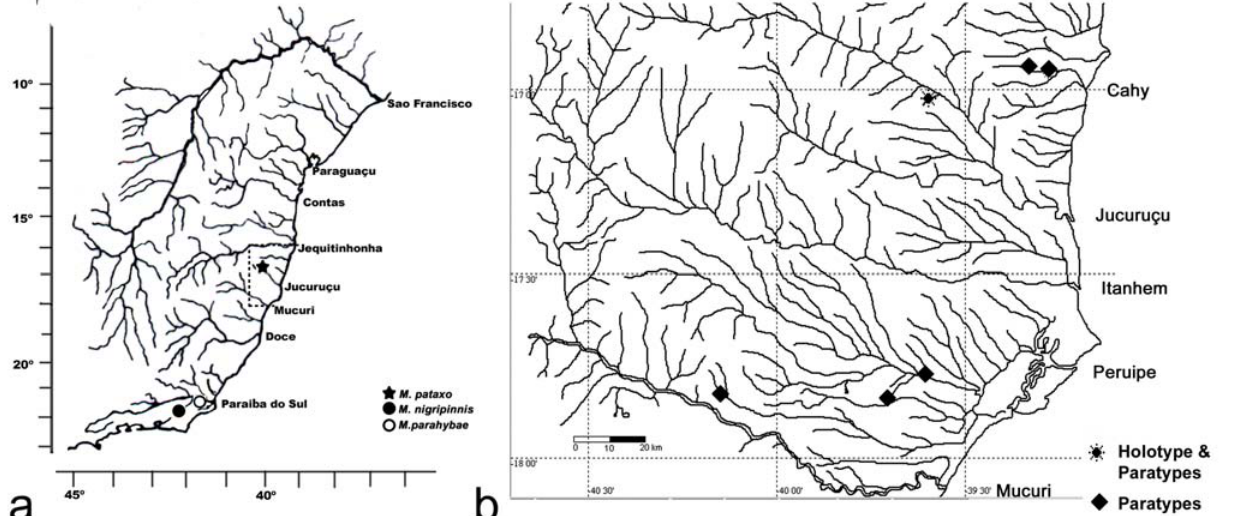
Fig. 9. a. Drainage map of eastern Brazil between rio São Francisco and rio Paraíba do Sul illustrating the distribution of the Microglanis species in the area. Dotted line indicates the study area. Symbols may represent more than one locality. b. Detail of collecting localities of Microglanis pataxo in the study area, between the rio Mucuri and rio